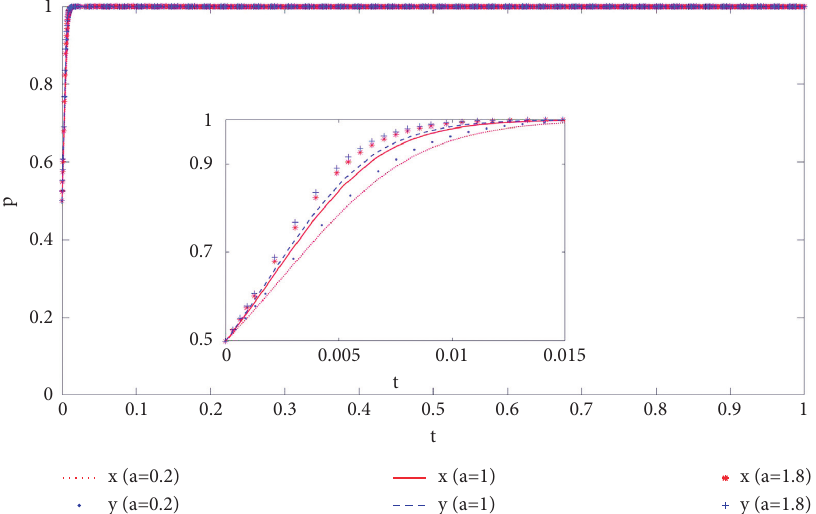
Figure 7: Influence of standardized cost subsidy on system evolution